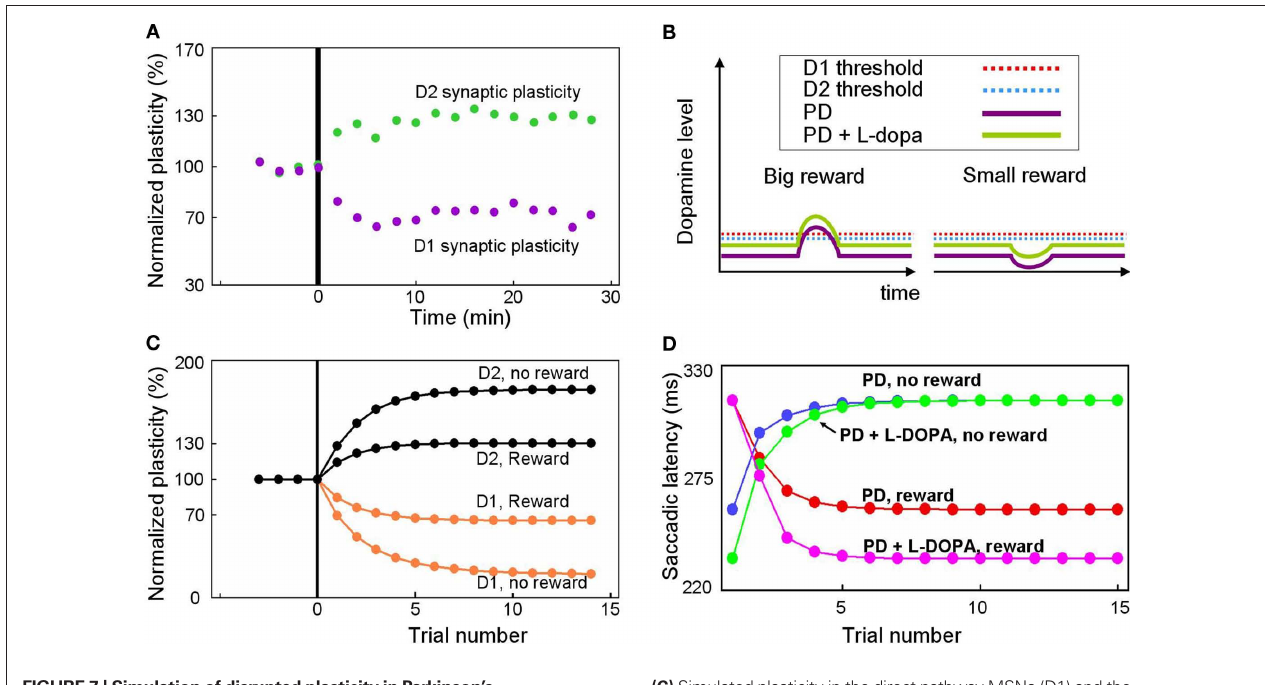
Figure 7 | Simulation of disrupted plasticity in Parkinson’s disease (PD). (A) Disrupted plasticity in MSNs (green and purple dots) in a rat PD model. When input stimulation was followed by excitation of a MSN repeatedly, the response of the MSN to the input changed gradually, in the directions opposite to control subjects. Data are from Shen et al. (2008), adapted with permission. (B) Hypothesized changes in the DA level and D1/D2 thresholds in PD and PD with l -DOPA. See text for